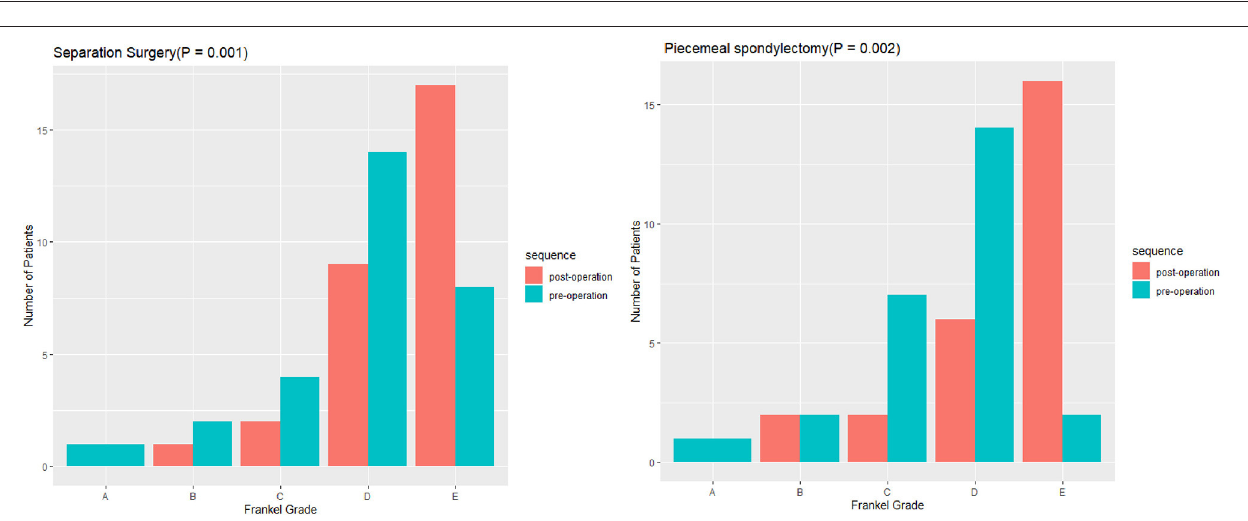
FIGURE 2 | Comparisons of preoperative and postoperative neurological statuses between piecemeal spondylectomy and separation